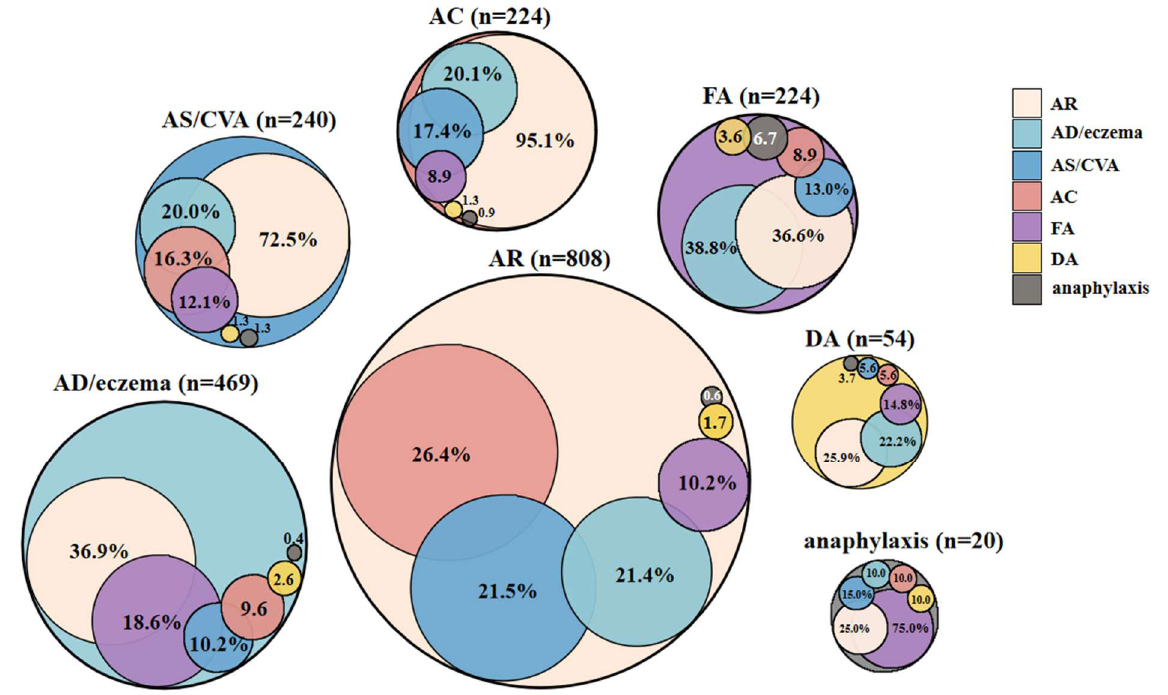
Figure 1. The pattern of allergic conditions in the 1273 patients. Physician-diagnosed allergic rhinitis (AR), asthma (AS)/cough variant asthma (CVA), atopic dermatitis (AD)/eczema, food allergy (FA), allergic conjunctivitis (AC), drug allergy (DA), anaphylaxis, and the overlap of the diagnoses in the study. For example, 26.4% of patients with physician-diagnosed AR also have AC diagnosis, 21.5% AS/CVA, 21.4% AD/eczema, 10.2% FA, 1.7% DA, and 0.6% anaphylaxis.